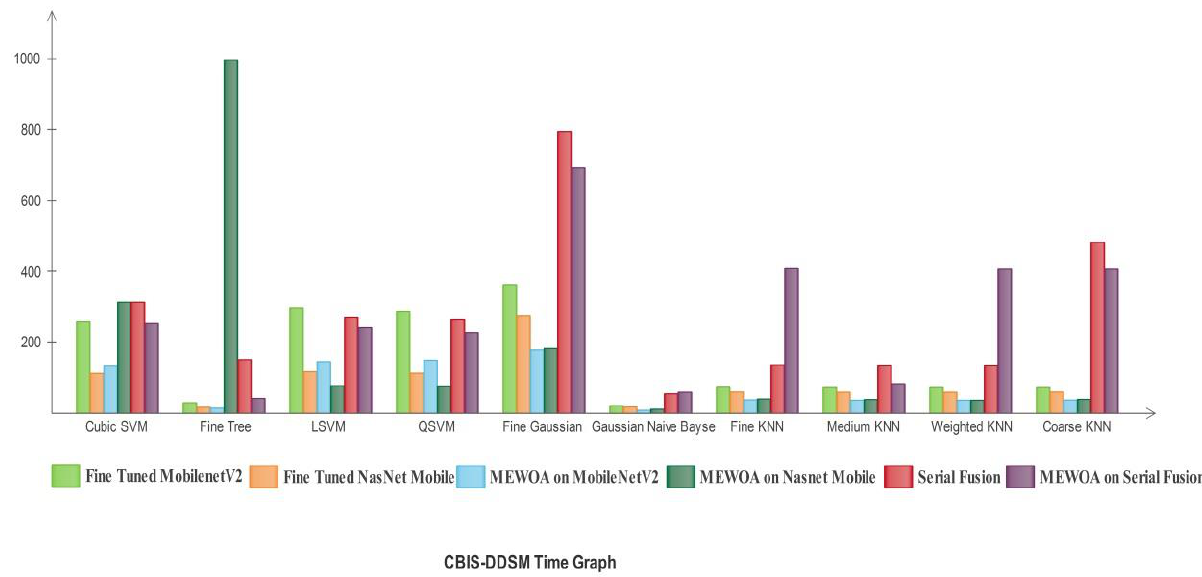
21 of 38 Figure 12. MEWOA on fusion TPR for CBIS-DDSM.